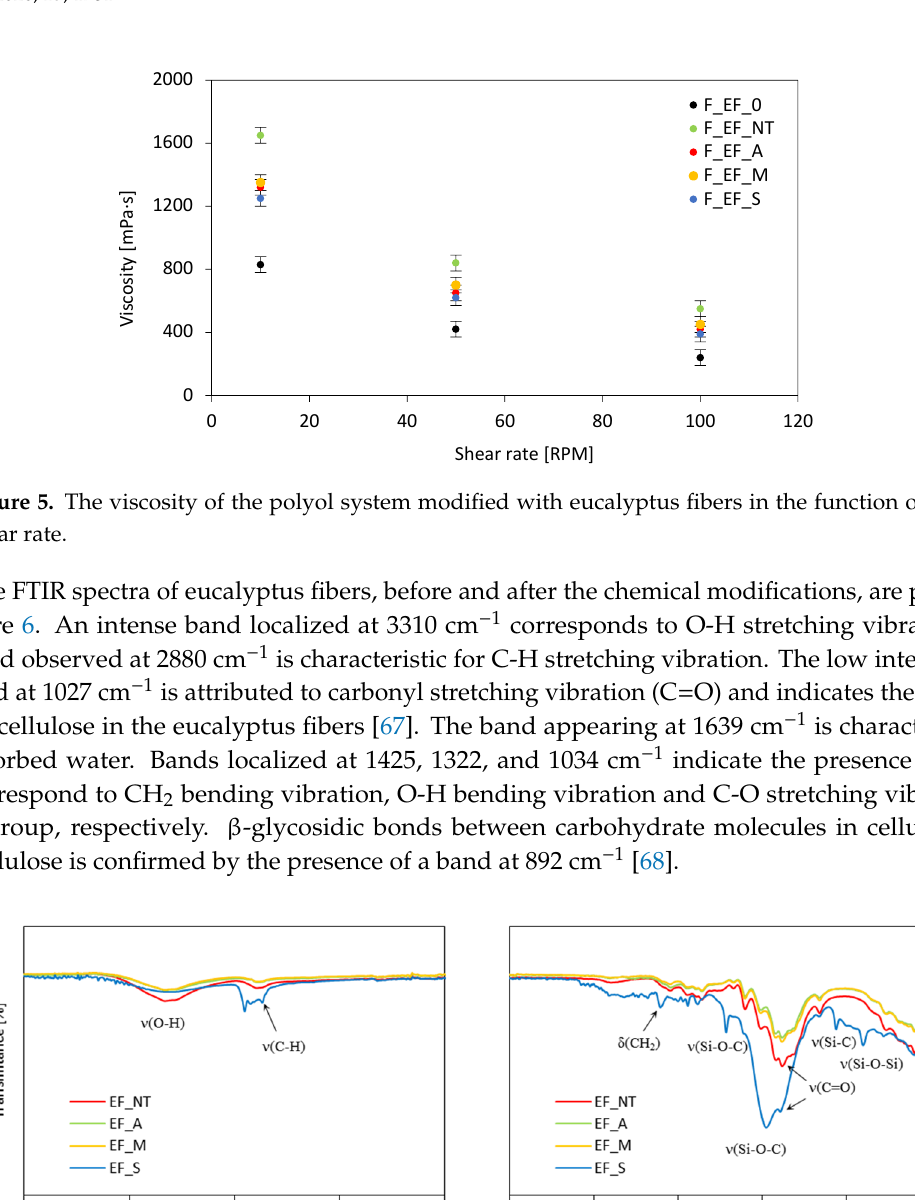
Figure 5. The viscosity of the polyol system modified with eucalyptus fibers in the function of the shear rate.